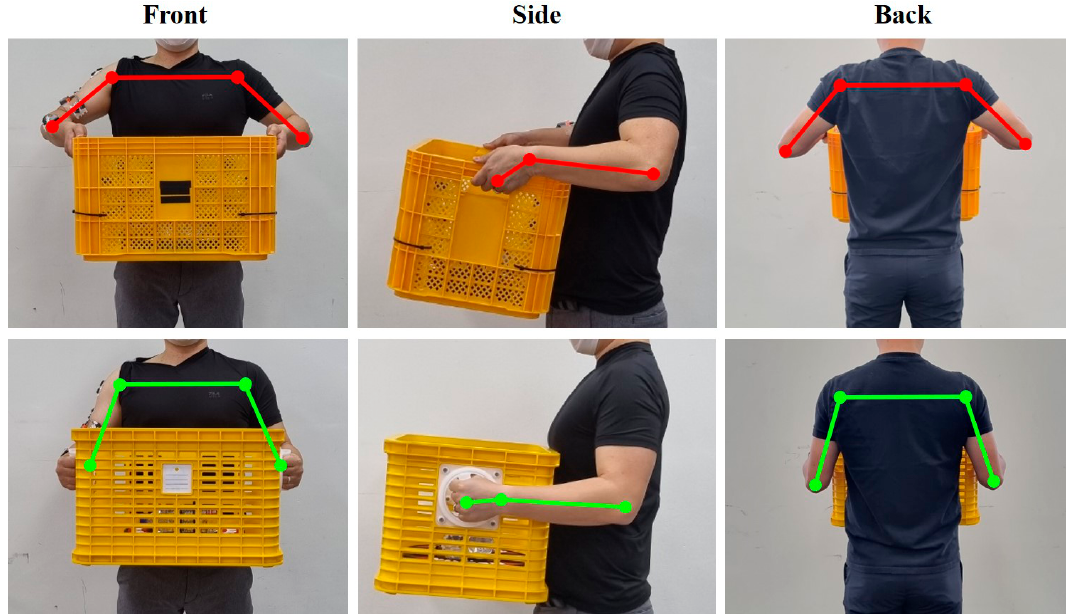
Figure 2. Basket types using in this experiment (red line, Typical Basket; green line, Rotational Handle Basket).